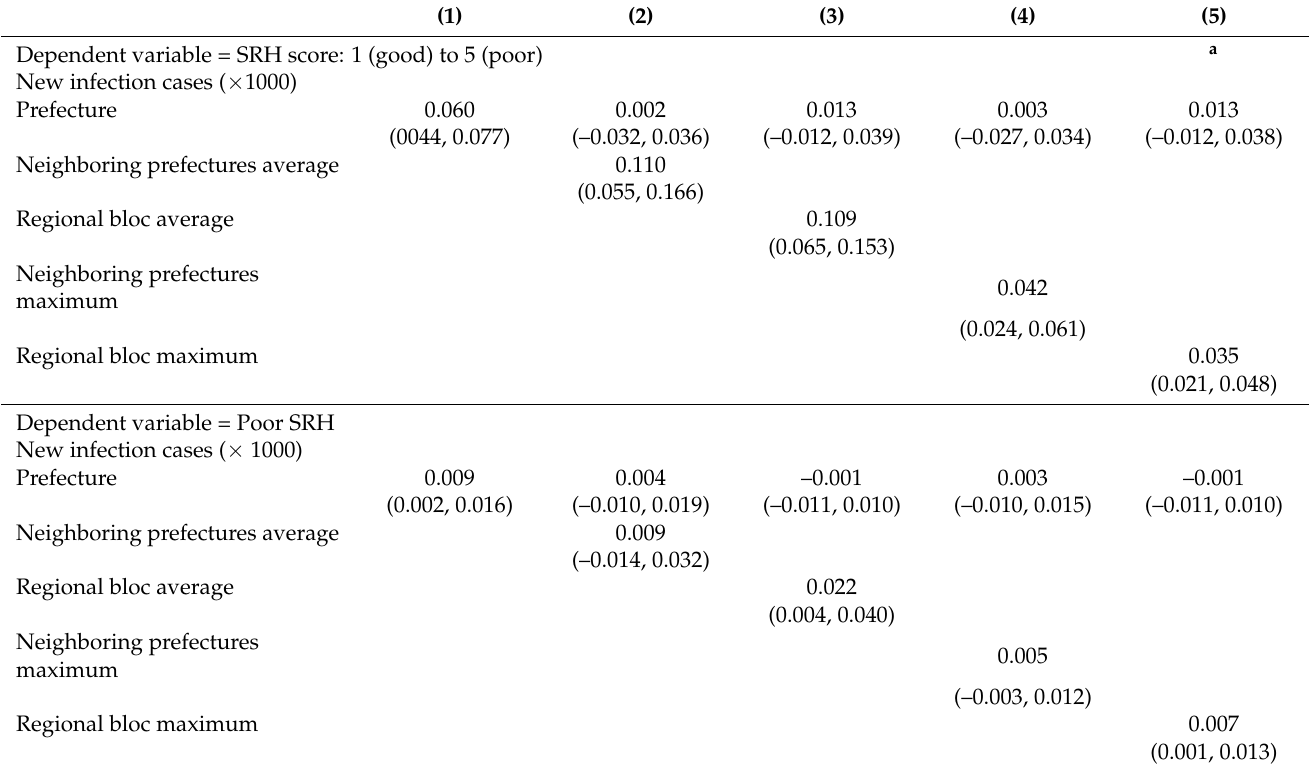
Table 4. Estimated association of new COVID-19 cases with self-rated health (SRH) a ( N = 4520 observations of 2260